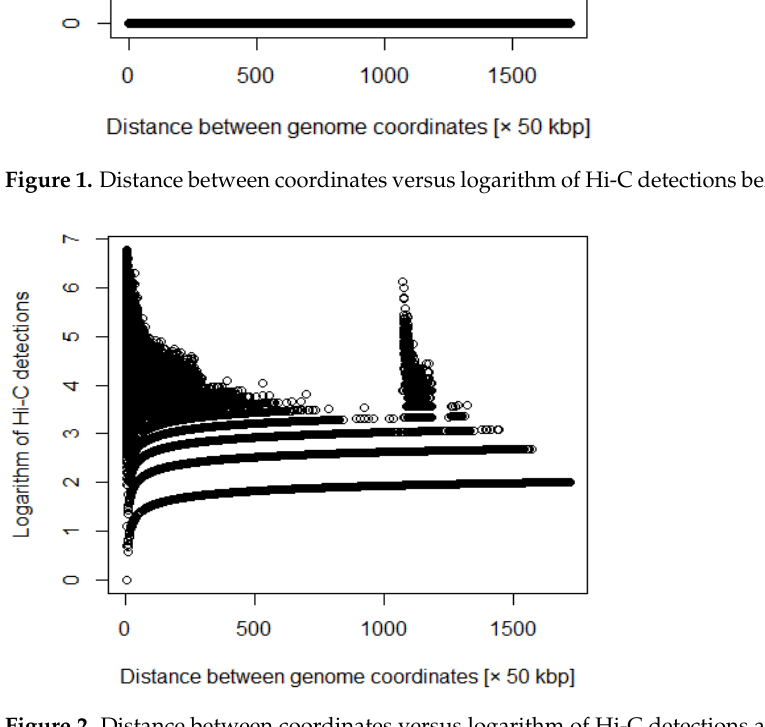
Figure 2. Distance between coordinates versus logarithm of Hi-C detections after adding weighting.